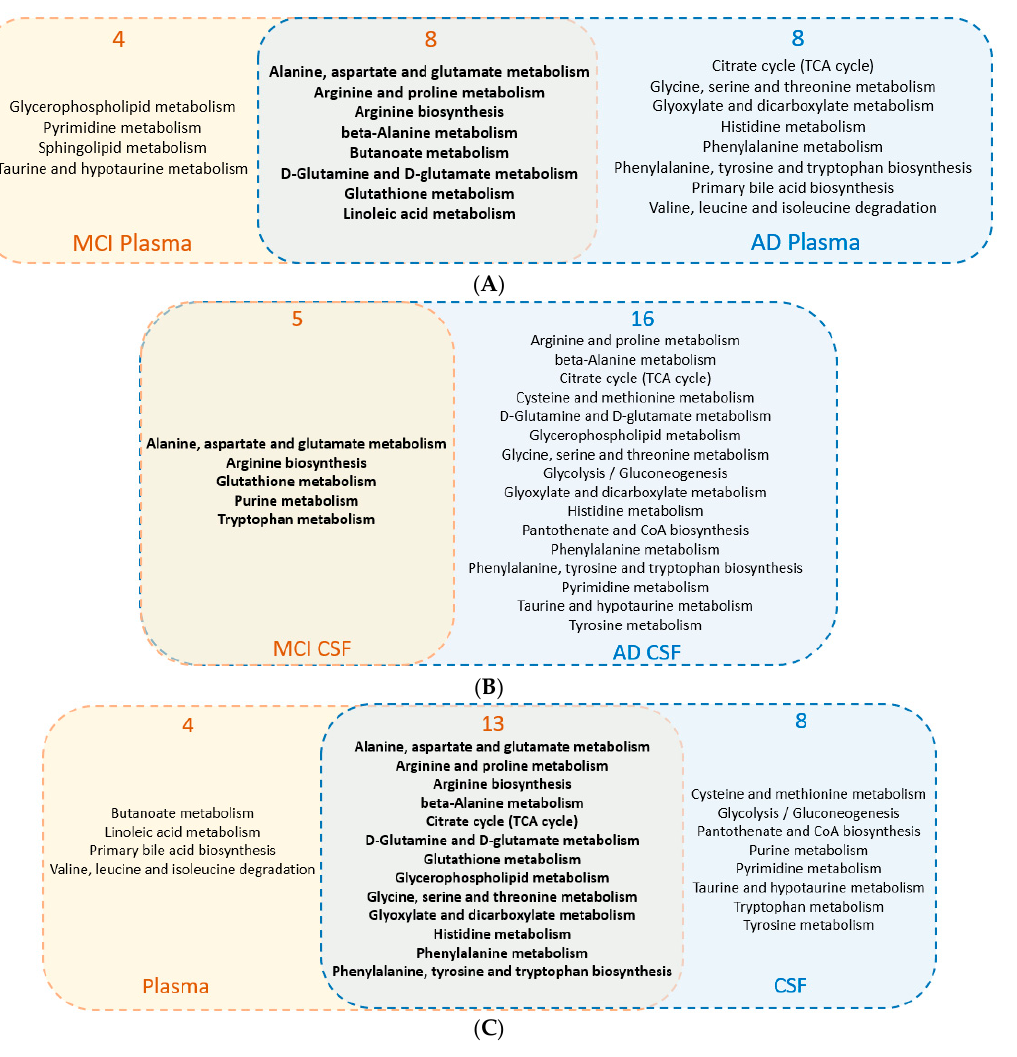
Figure 2. Disturbed metabolic pathways analysis in humans, comparing different disease stages with healthy controls: ( A ) Intersection analysis of metabolic pathways among MCI and AD groups in plasma samples. Yellow circles are all the disturbed pathways in MCI plasma samples, blue circles are all the disturbed pathways in AD plasma samples, and the middle intersection is pathways in common among MCI and AD in plasma samples. ( B ) Intersection analysis of metabolic pathways among MCI and AD groups in CSF samples. Yellow circles are all the disturbed pathways in MCI CSF samples, blue circles are all the disturbed pathways in AD CSF samples. All the MCI pathways overlapped with AD pathways in CSF samples. ( C ) Intersection analysis of metabolic pathways among plasma and CSF samples. Yellow circles are all the disturbed pathways in plasma samples, blue circles are all the disturbed pathways in CSF samples, and the middle intersection is pathways in common among plasma and CSF